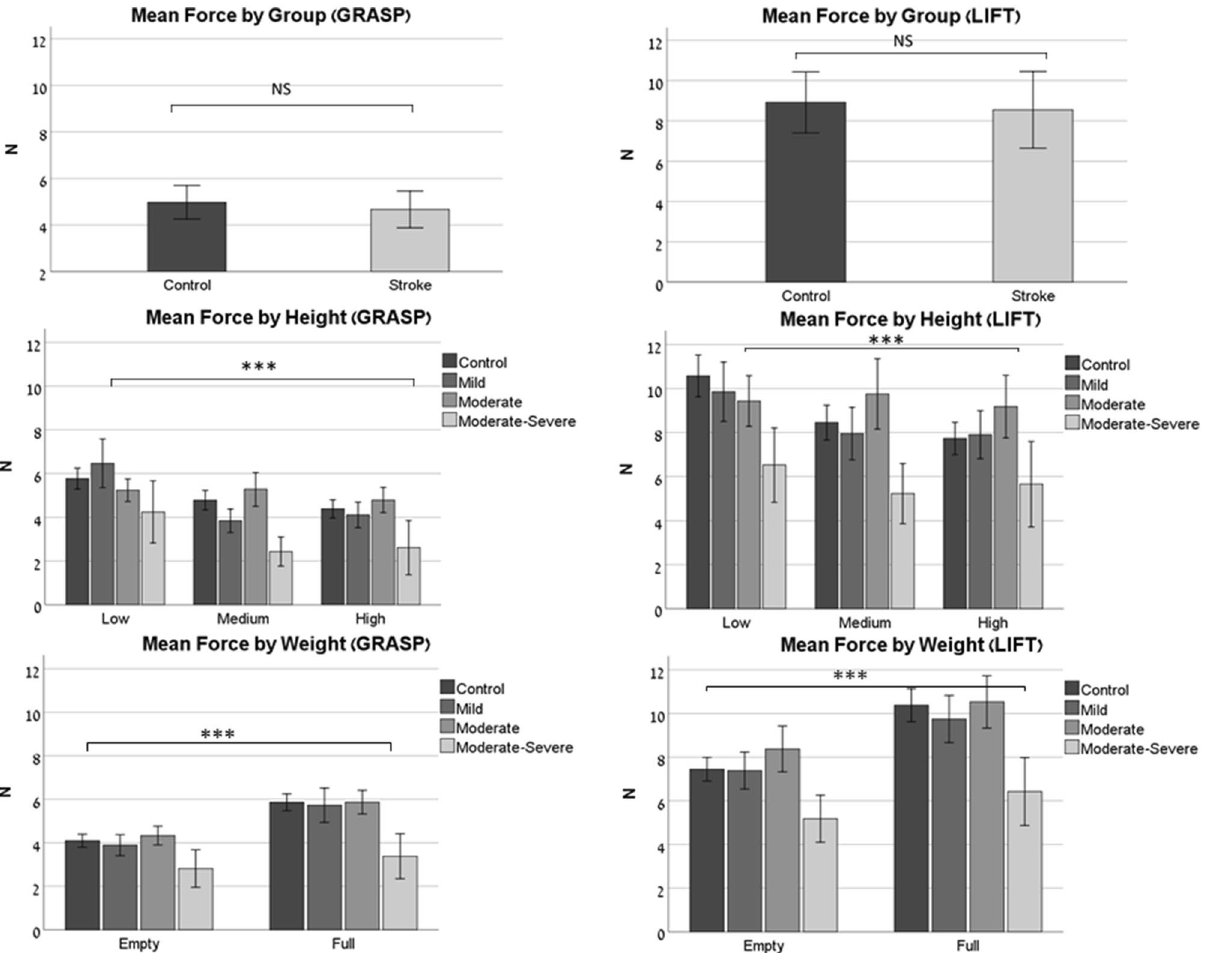
Figure 2. Mean force (N). Mean-force values for the Grasp phase ( left ), and the Lift phase ( right ). The top row shows the results by group (control/stroke). The middle row shows the results by height (low/medium/high), and by sub-group (control/mild impairment/moderate impairment/moderate-severe impairment). The bottom row shows the results by weight (empty/full cup, corresponding to light/heavy weight), and by sub-group. Asterisks denote the p value: * p ≤ 0.05, ** p ≤ 0.01, *** p ≤ 0.001. Abbreviations: